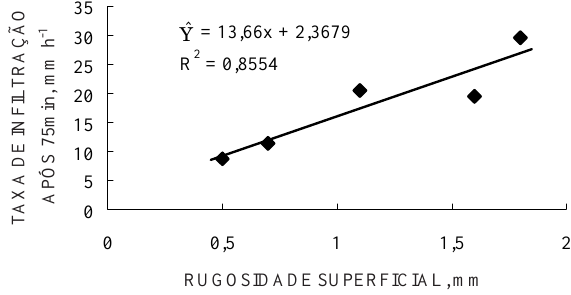
Figura 1. Relação entre a taxa de infiltração após 75 min, 55 dias após o preparo do solo e semeadura, e a rugosidade superficial medida logo após o preparo e